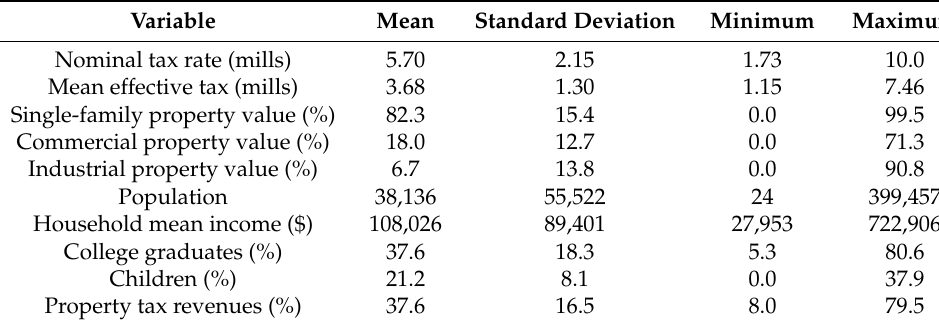
Table 1. Summary statistics ( n =